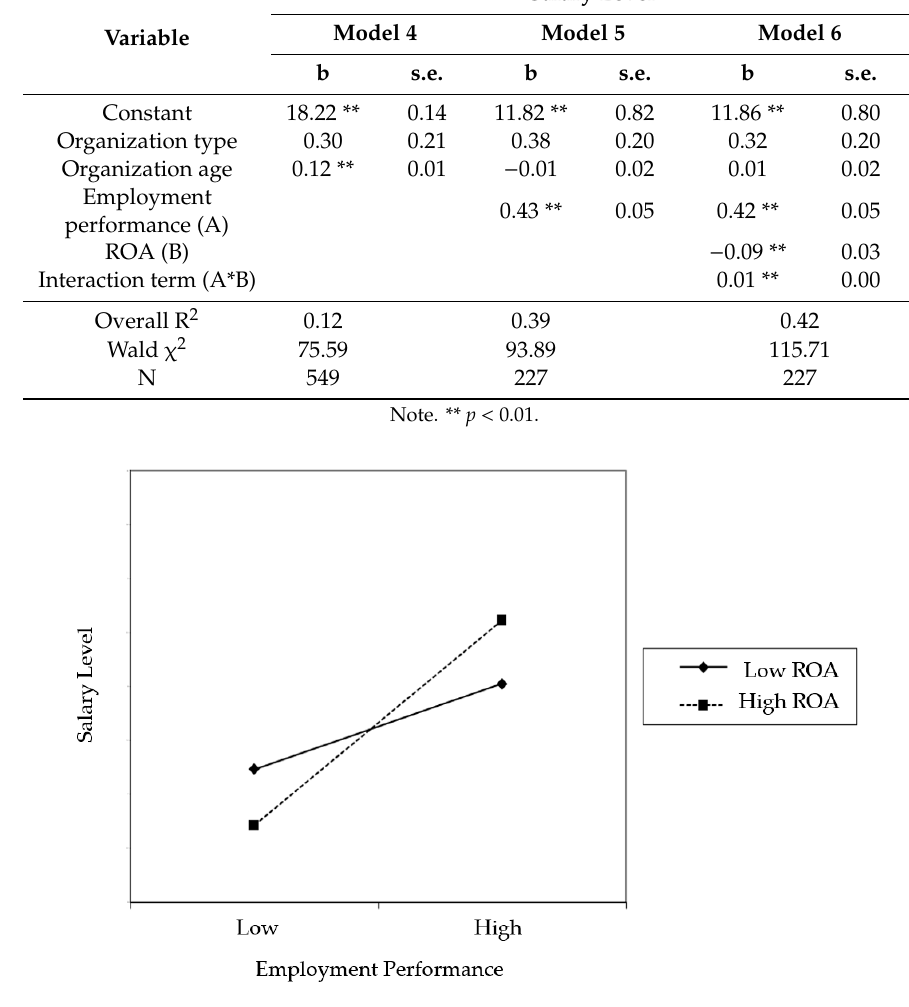
Figure 2. Moderation e ff ect of return on assets. Figure 3. Moderation effect of return on assets.